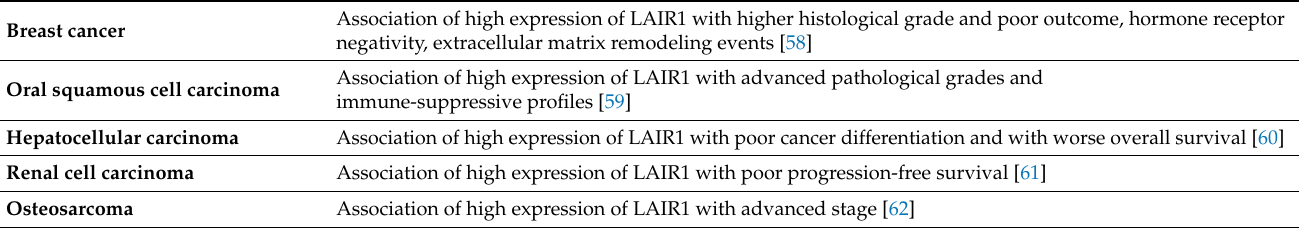
Table 1. Solid cancer models with clinical observations linking higher expression of LAIR1 to cancer